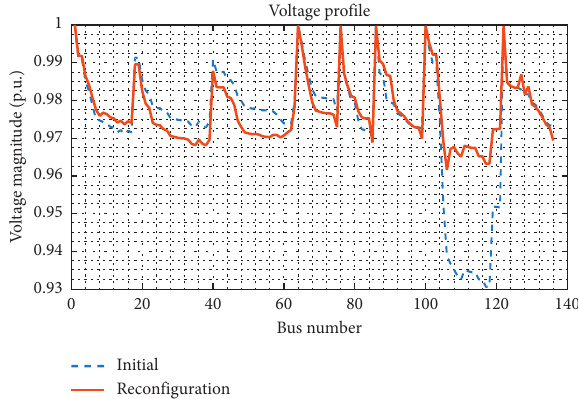
Figure 16: Voltage profile for the 136-bus system before and after